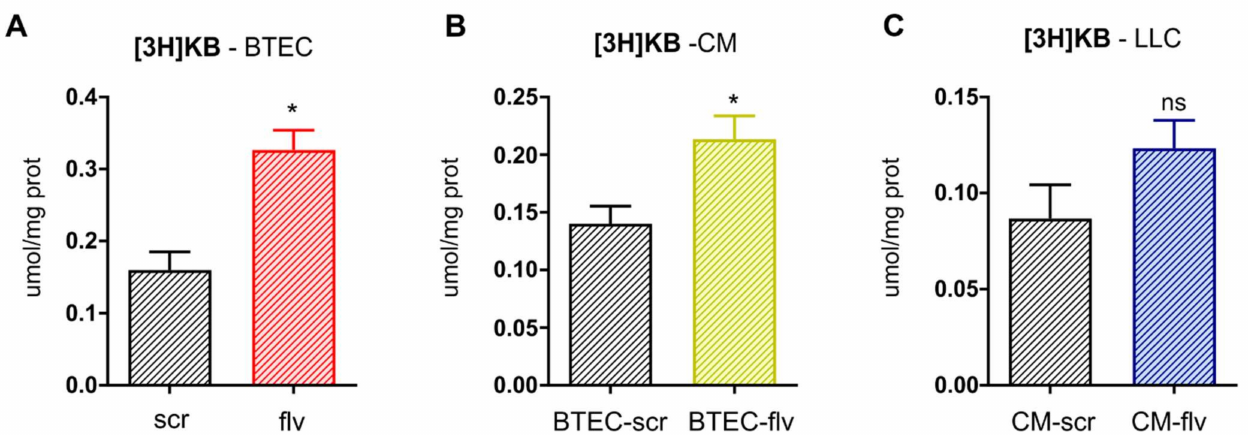
Figure 5. KBs derived from FLVCR1a-deficient TEC can be transferred to the CC. ( A – C ) Quantification of [ 3 H]-acetoacetate by high-performance liquid chromatography (HPLC) ( A ) in FLVCR1a -silenced (flv) and control (scr) BTECs lysates, ( B ) in FLVCR1a -silenced (BTEC-flv) and control (BTEC-scr) BTECs-derived CM collected after 72 h of cell culture, and ( C ) in LLC cells lysates after 24 h of conditioning with FLVCR1a -silenced (CM-flv) and control (CM-scr) BTECs-derived CM. Data are expressed as µ mol/mg cell proteins and represent means ± SEM, n = 3. For statistical analyses, an unpaired Student’s t -test was used. * p < 0.05; ns, not